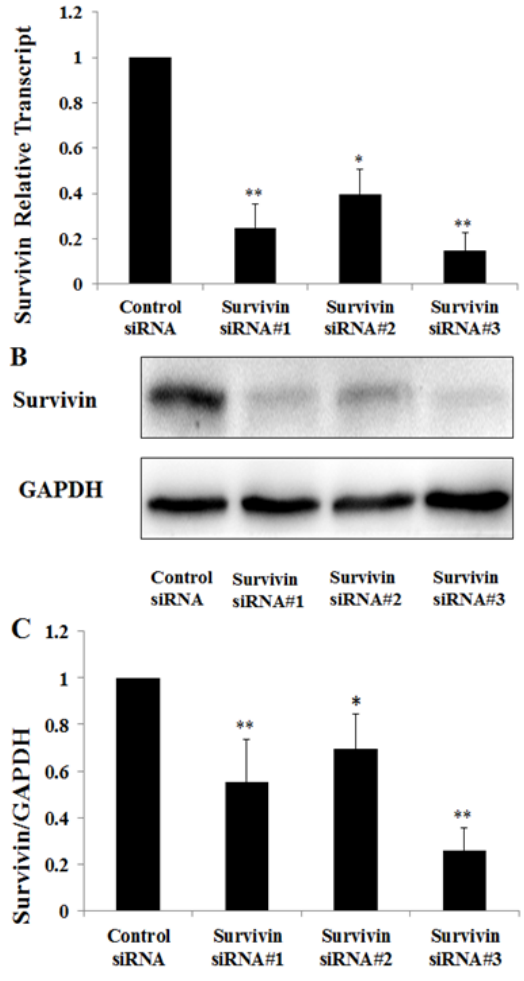
Figure 3. Screening of high effective survivin siRNA. The total RNA ( A ) and protein ( B , C ) expression of survivin decreased significantly after transfection with survivin siRNA 100 pmols compared to negative control siRNA, especially survivin siRNA#3 group. Data are presented as mean ± SD. n = 3. * p < 0.05, ** p <